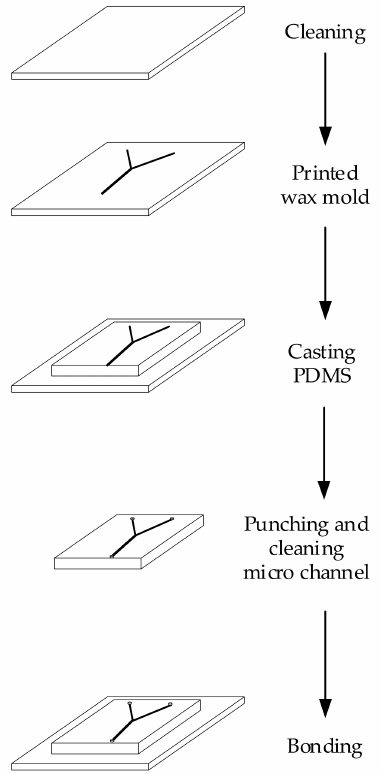
Figure 3. Process for the preparation of a polydimethylsiloxane (PDMS) microfluidic